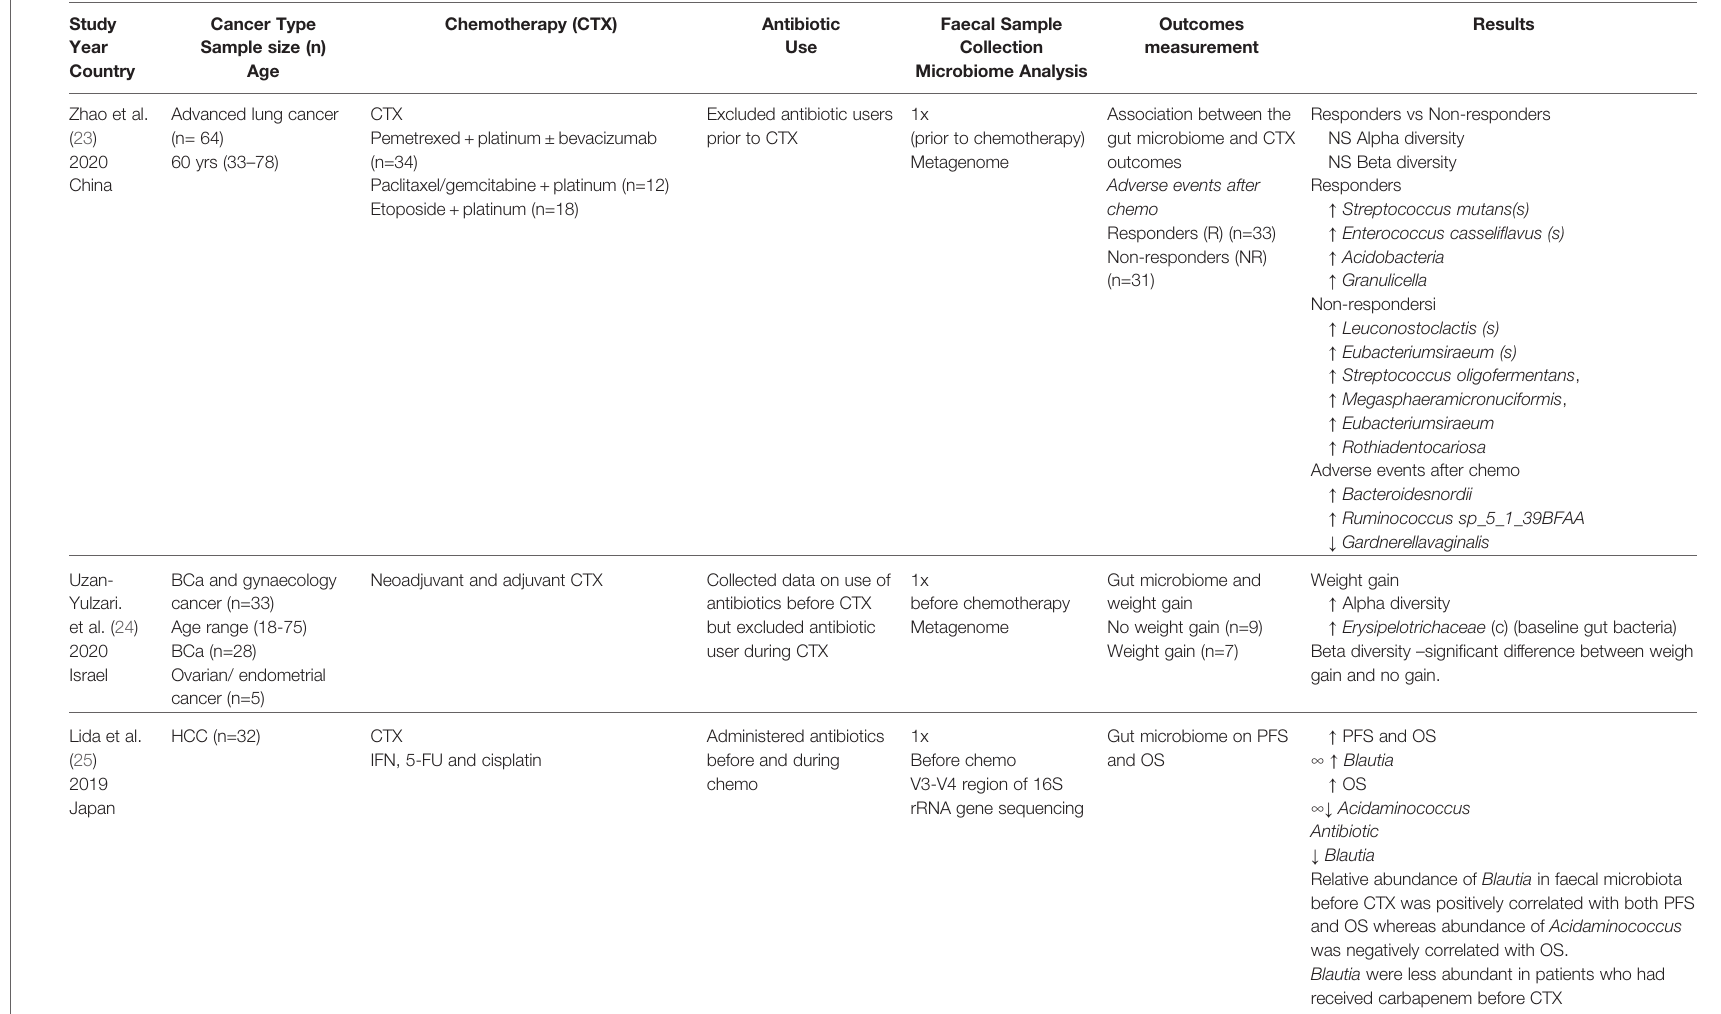
TABLE 1 | The gut microbiome in chemotherapy